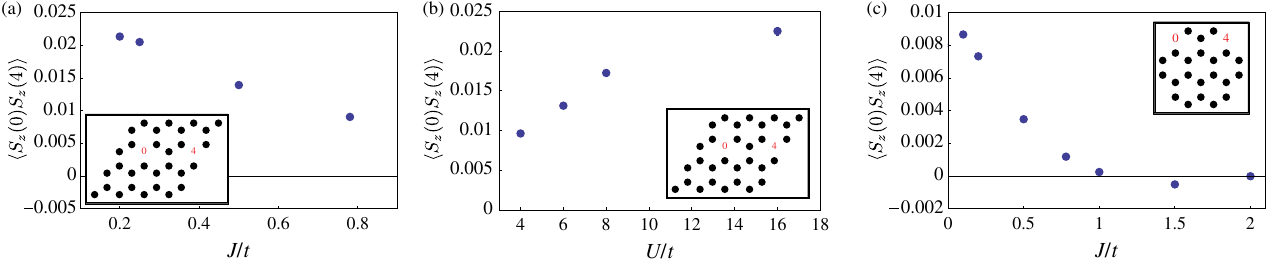
i Þ S j Þi for farthest pair of sites i , j (see insets), with DMRG ground state projected FIG. 12. Value of spin-spin correlation function h S z ð z ð into sector having center-of-mass momentum Γ , and C 6 eigenvalue exp ð − i π = 3 Þ on 32-site sample: (a) t - J model, (b) Hubbard model. (c) On 24-site sample, the t - J model DMRG ground state is projected to exp ð − i 2 π = 3 Þ eigenvalue sector of C 6 : the spin correlation vanishes with crossover to ( d þ id )-like regime. Averaging over translationally and rotationally related pairs is included in all measurements to reduce the statistical error. The correlation consistently grows throughout CSDW or SCCL phase with larger U (smaller J